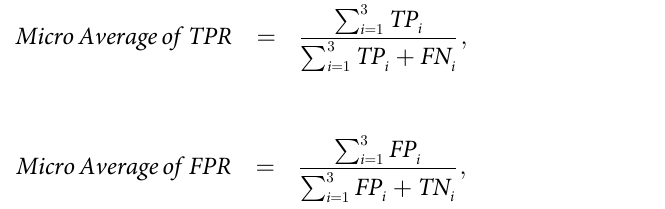
based on the micro-average of the TPR and False Positive Rate (FPR) values obtained for each class at different thresholds. The FPR is defined as the ratio of wrongly classified positive cases (false-positives) among all actual negative cases (false positives and true-negatives). The reason for using the micro-averaging technique is that we have an imbalanced dataset. This technique aggregates the contribution of the three classes to compute the average of TPR and FPR as fol- lows